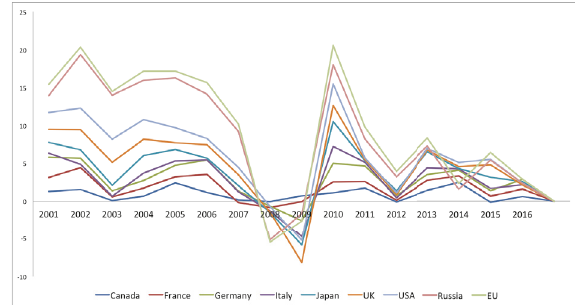
Figure 2: Labour productivity, annual growth rate(%), 2000−2016 . Source: